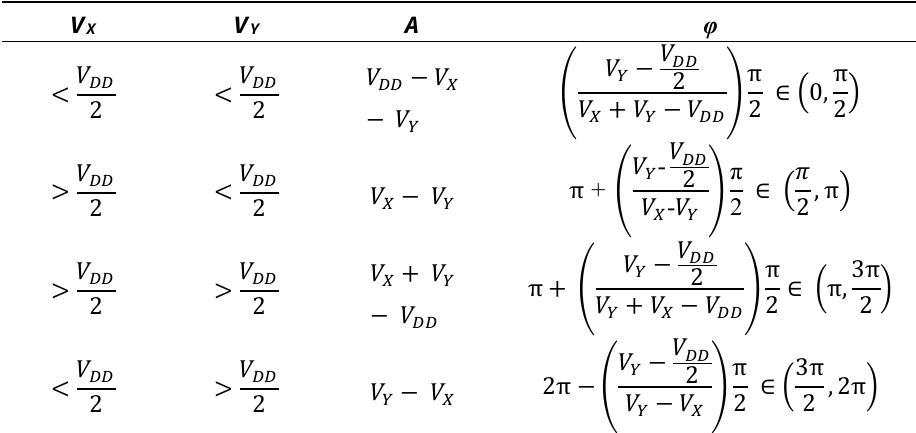
Table 1. Amplitude and phase recovery equations for an input square